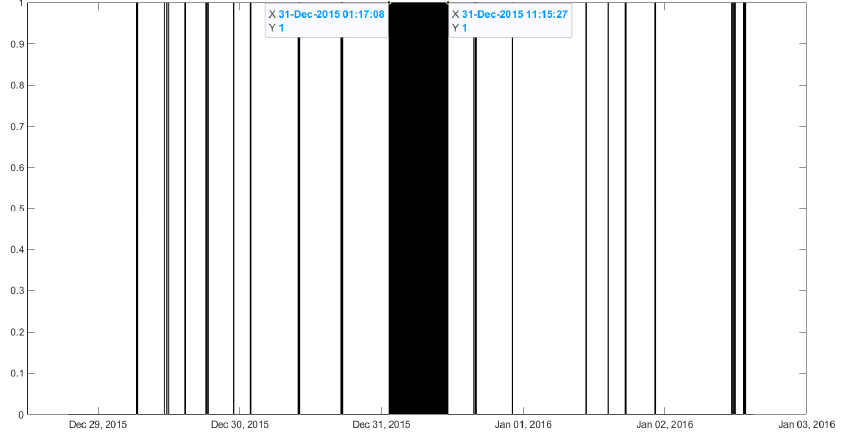
Figure 5. Test data attacks.